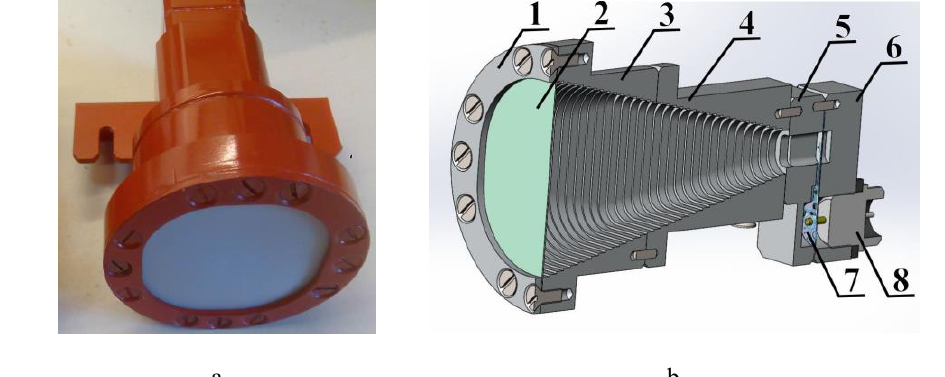
Fig . 1. Complete K a -band parametric reflector (a) and its 3-D sectional view